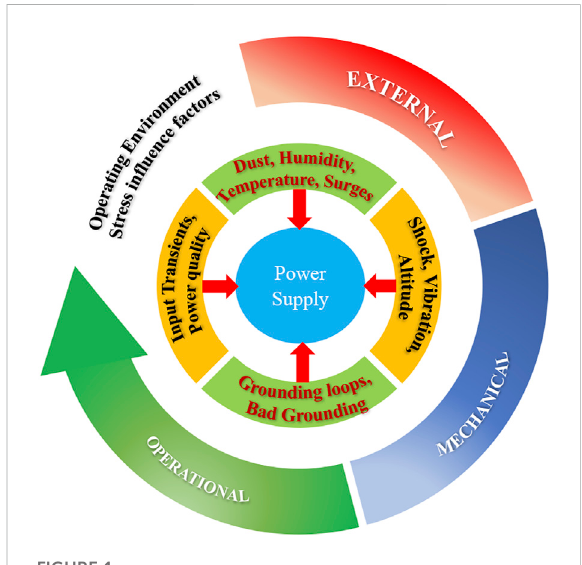
FIGURE 1 Expected transients, environment and installation conditions for a product to operate in the fi